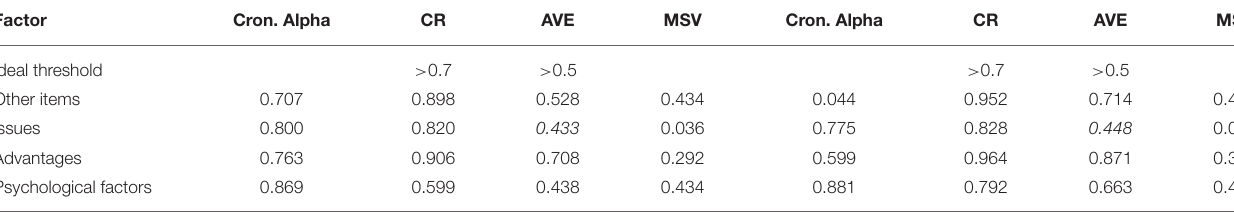
TABLE 10 | CFA internal